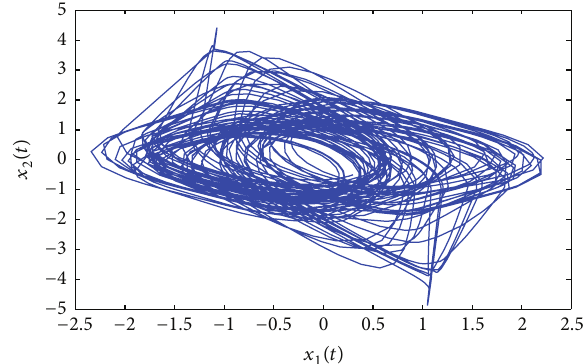
Figure 1: The chaotic behavior of system (25) with the initial values 𝑥 1 (𝑠) = 0.3 , 𝑥 2 (𝑠) = −0.5 , for 𝑠 ∈ [−1,0] .